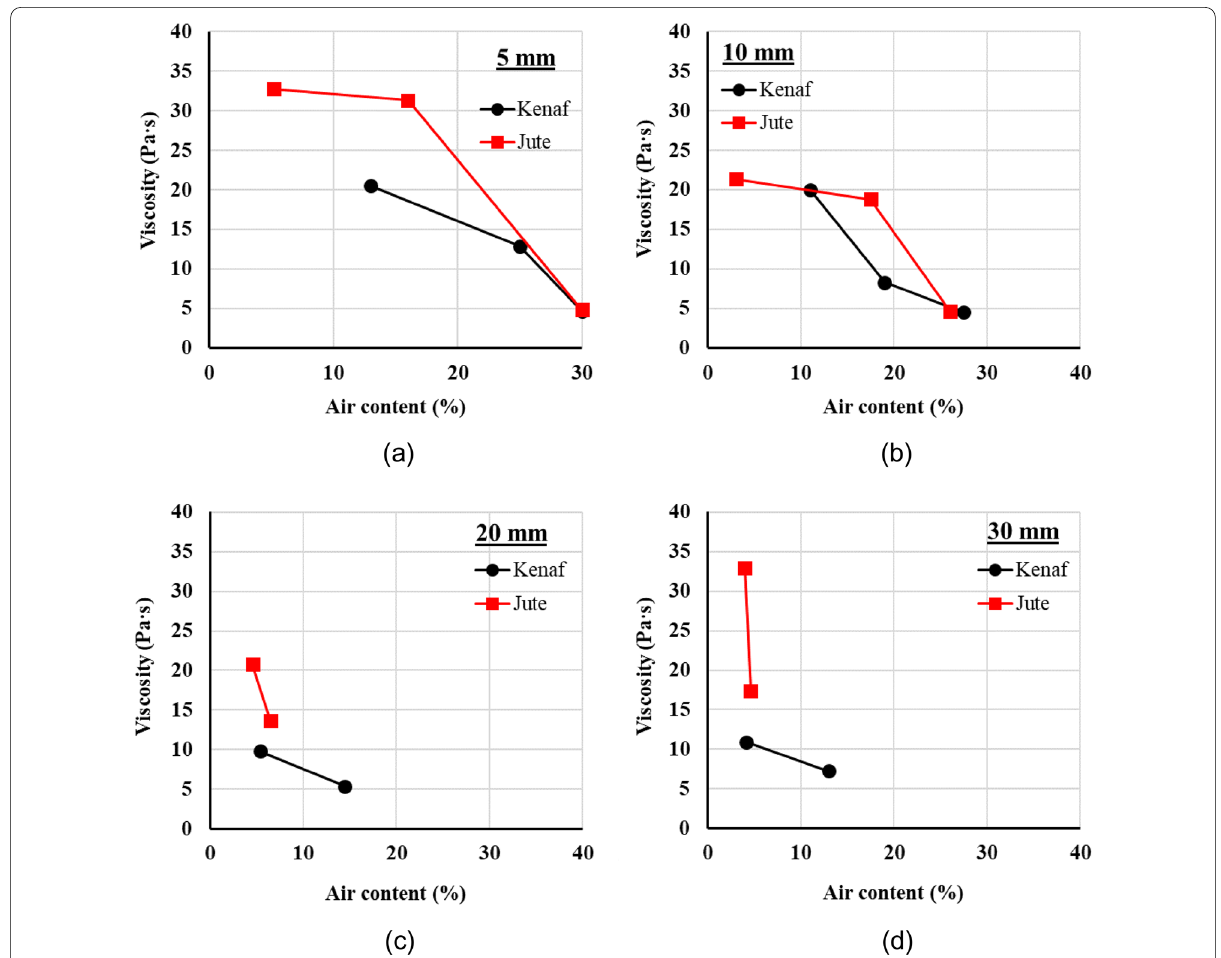
Fig. 14 Correlation between viscosity and air content of NFRCCs for the same fiber length: a 5 mm; b 10 mm; c 20 mm; d 30 mm